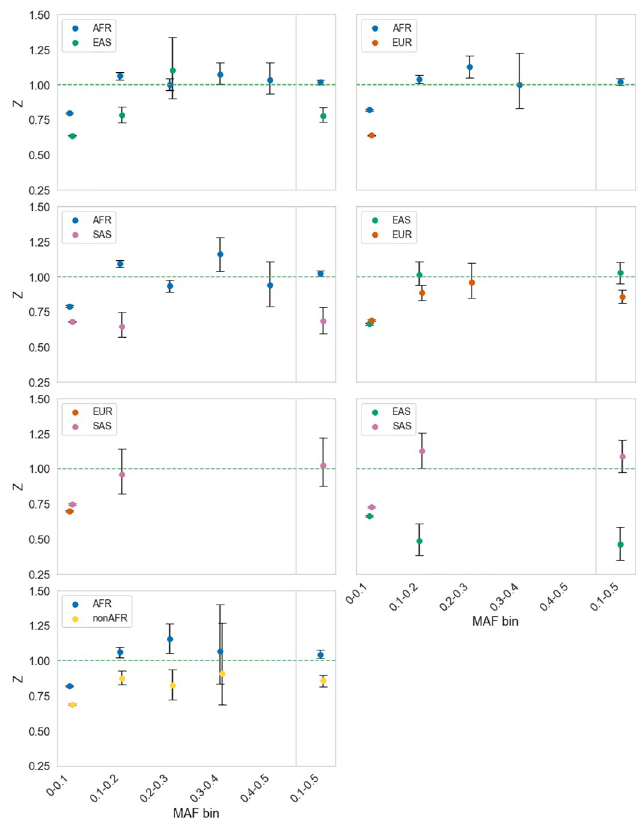
Fig 2. Testing for balancing selection in human. The value of Z is plotted against the frequency of shared and private polymorphisms, for pairs of populations: AFR, EAS, EUR, and SAS. In each panel, we show the value of Z for a comparison of 2 populations using the private polymorphisms from each, the population used being indicated in the plot legend. Data binned by minor allele frequency bins of size 0.1 on the x-axis. The final bin is 0.1–0.5 (i.e., all data minus the lowest frequency bin). Only data points in which there were at least 20 polymorphisms for all polymorphism categories were plotted, because the confidence intervals were very large otherwise. Code to extract and analyse the data can be found at https://github.com/vivaksoni/test_for_balancing_selection. The data underlying this figure can be found in S3 Data. AFR, Africans; EAS, East Asians; EUR, Europeans; SAS, South Asians.